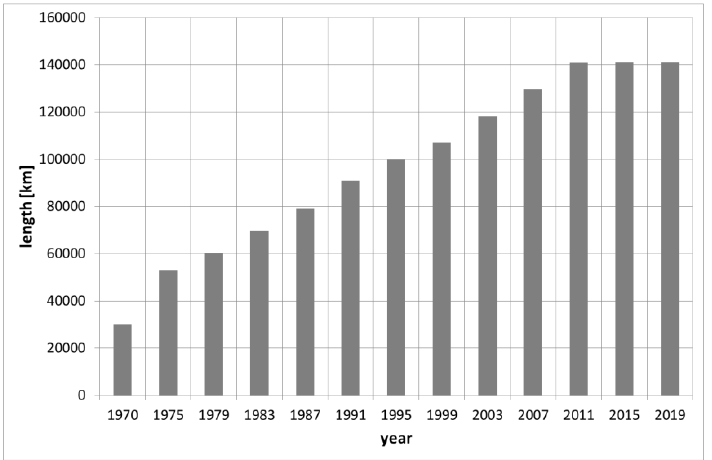
Figure 1. Top 14 consumers of natural gas in 2018.